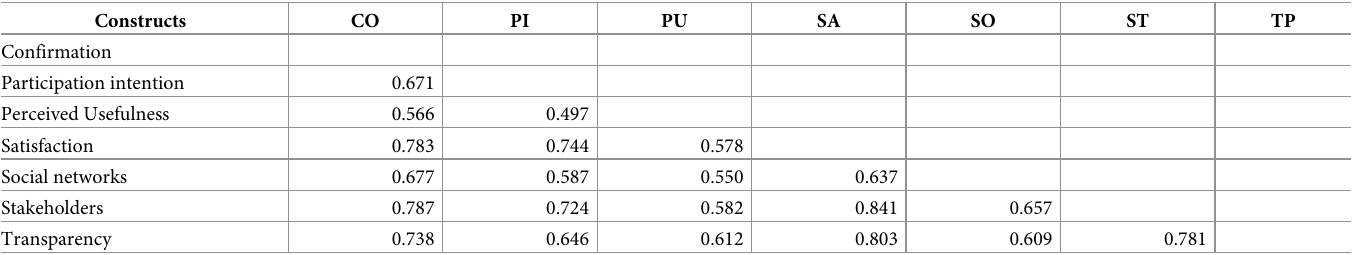
Table 5. Heterotrait-Monotrait ratio